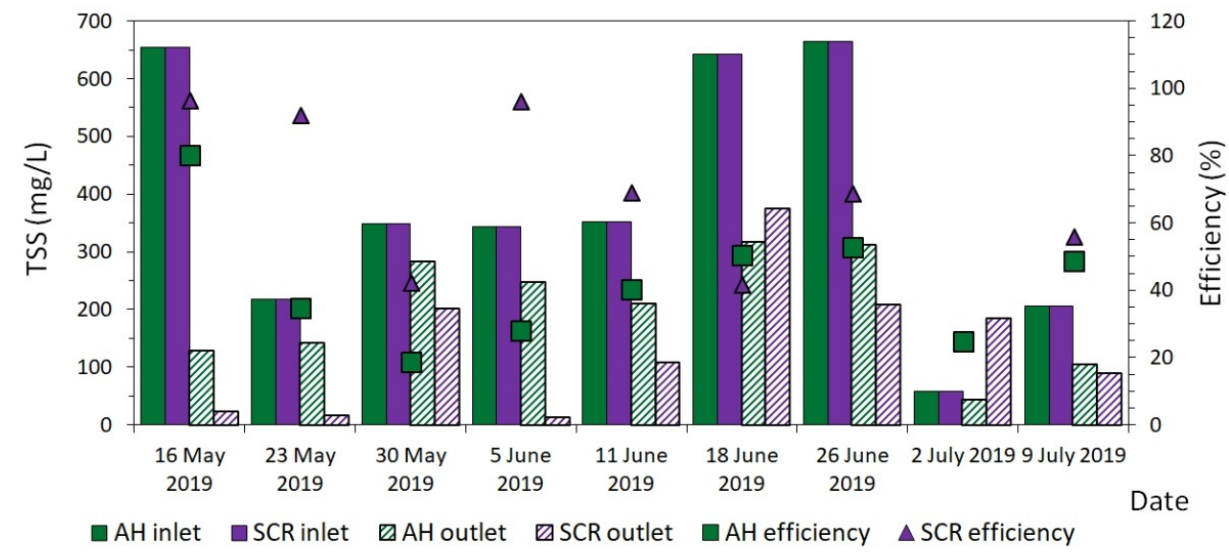
Figure 10. Inlet and outlet TSS and removal efficiencies at preliminary stage.